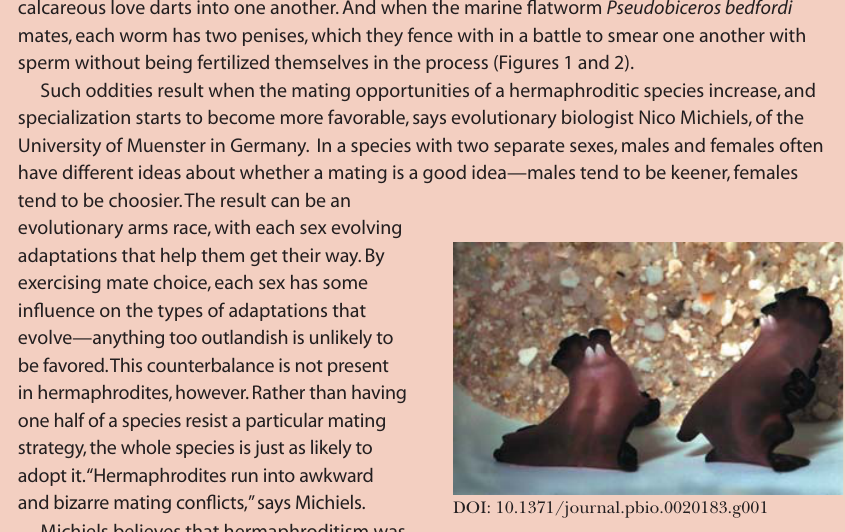
Figure 1. Two Individuals of Pseudobiceros bedfordi About to Have a Sperm Battle Species of the fl atworm genus Pseudobiceros are hermaphroditic and have two penises that are used to inject sperm into the partner. P. bedfordi is exceptional in that it applies sperm onto the partner’s skin rather than injecting it. Photo courtesy of Nico